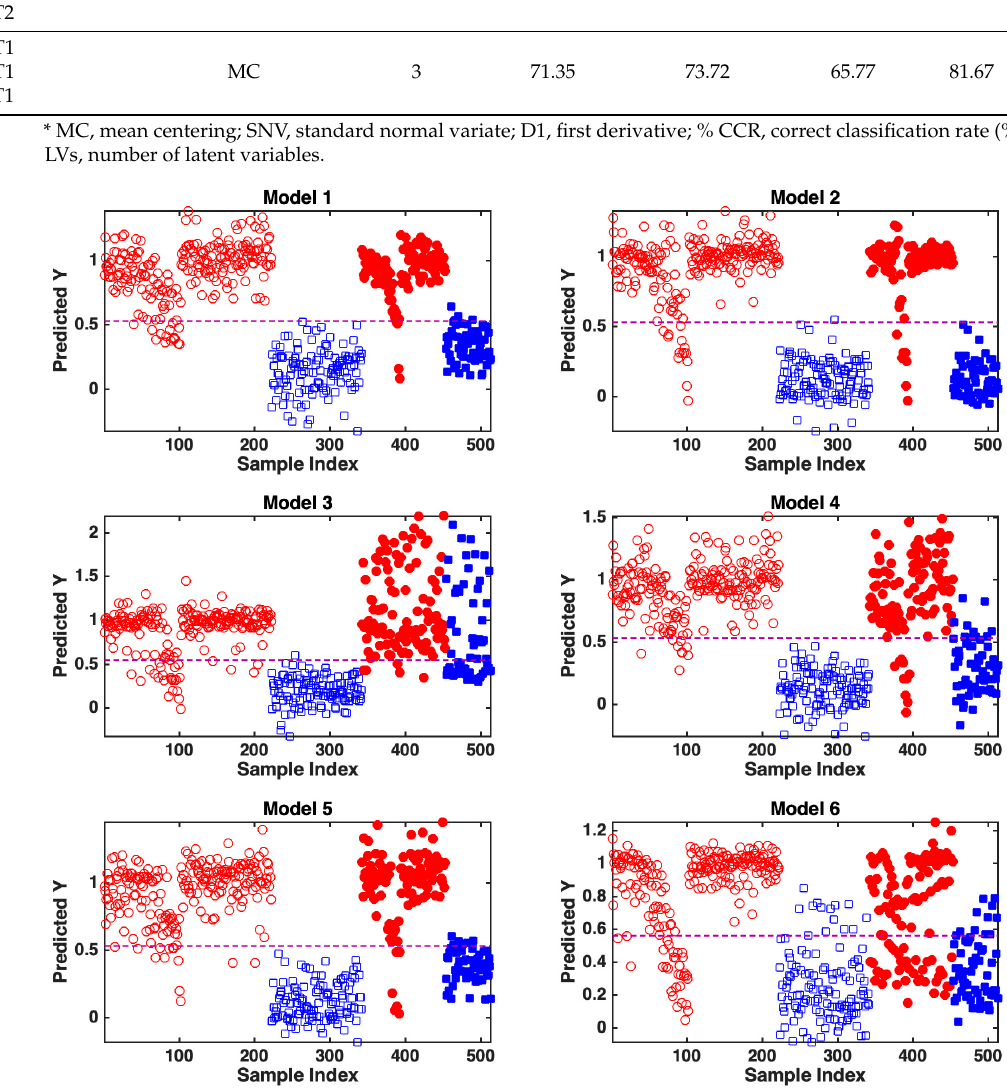
Figure 1. Graphical representation of the predictions of the different PLS-DA models on their respective training (empty symbols) and test (filled symbols) samples. Legend: red circles, spiked drinks; blue squares, pure drinks.